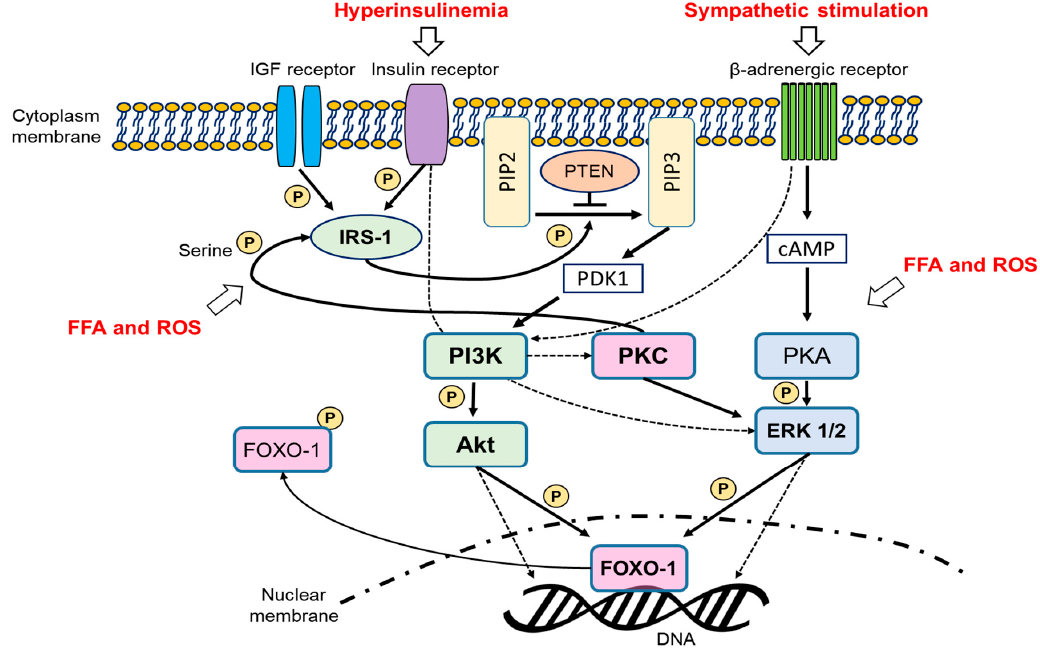
Figure 2. Suggested and integrated molecular signalling possibly related to PCOS development. Solid lines indicate direct effects, and dotted lines, indirect effects. PIP2 = phosphatidylinositol-4,5- bisphosphate, PIP3 = phosphatidylinositol-3,4,5-trisphosphate.